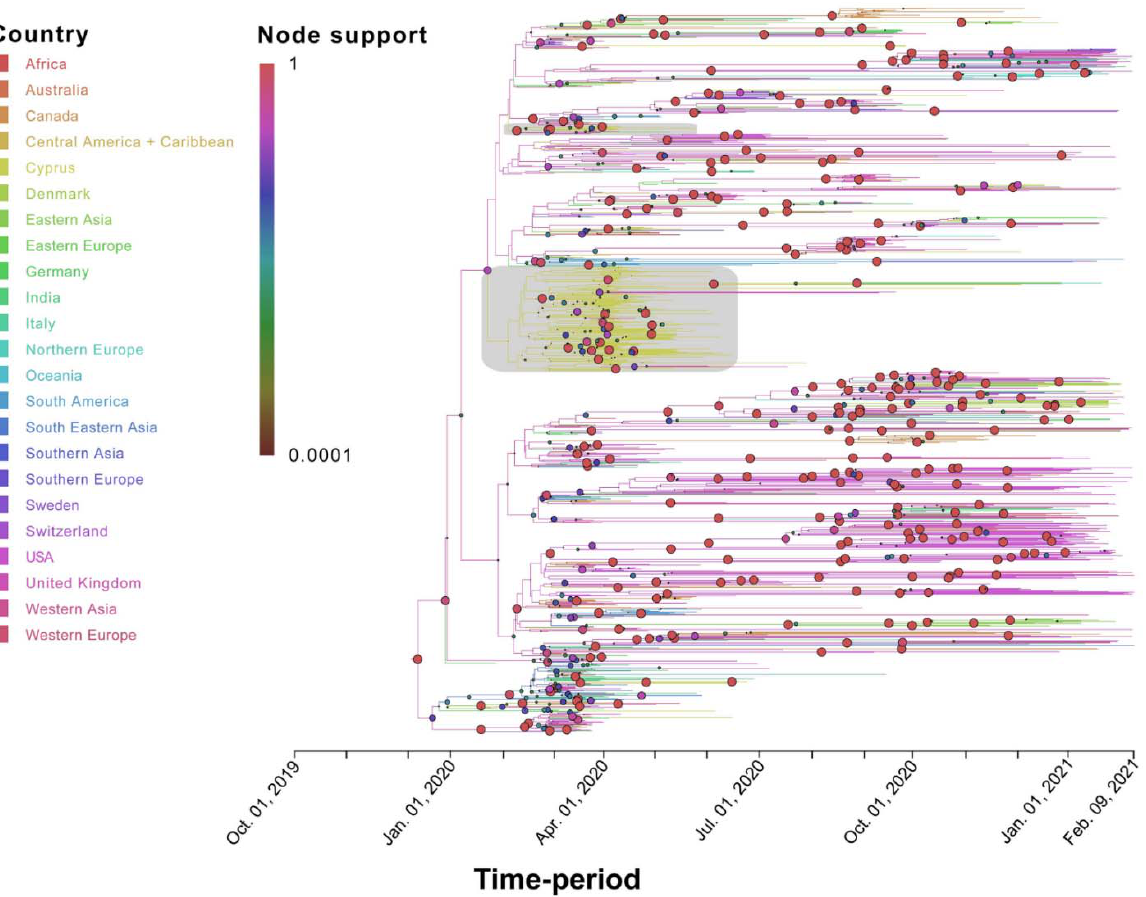
Figure 5. Time-scaled migration history for the B.1.1.x dataset. The link between branch color and the inferred location (Country) is shown in the top left of the figure. The size and color of the circles at the nodes (representing inferred common ancestors) indicate their posterior support (node support); the level of node support (highest = 1 and lowest = 0.0001) corresponds to the size of the circle (higher support = larger circle size). The link between color and posterior node support is shown in the top left of the figure. The gray-shaded boxes indicate two clades in the MCC summary tree that consist almost uniquely of Cypriot taxa detected in April and May 2020. The x -axis representing the time-period of the reconstruction was generated by the maximum clade credibility summary tree.